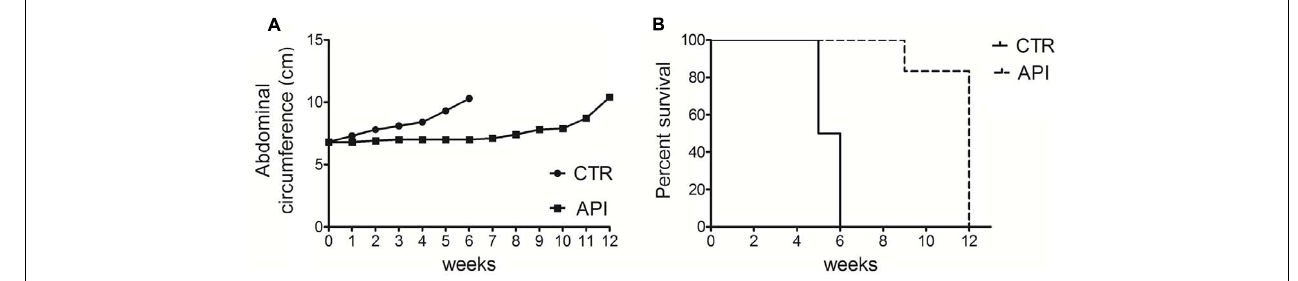
FIGURE 10 | Apigenin reduced tumor growth and increased the survival in C57BL/6 mice intraperitoneally transplanted with MM #40a cells. (A) Differences in mean abdominal circumferences between C57BL/6 mice treated with API or with DMSO-PBS (CTR). (B) Differences in the mean survival duration of C57BL/6 mice treated with API or with DMSO-PBS (CTR). The numbers of inoculated mice are reported in the Section “Materials and Methods”. TABLE 2 | Analysis of the survival of C57BL/6 mice after treatment with API by the log-rank test (Mantel-Cox). Variable Contrast Hazard Ratio 95%Hazard Ratio Confidence Limits Median Survival (weeks) p Value Lower Upper Treatment CTR vs API 23.17 3.617 148.4 5.5 vs 12